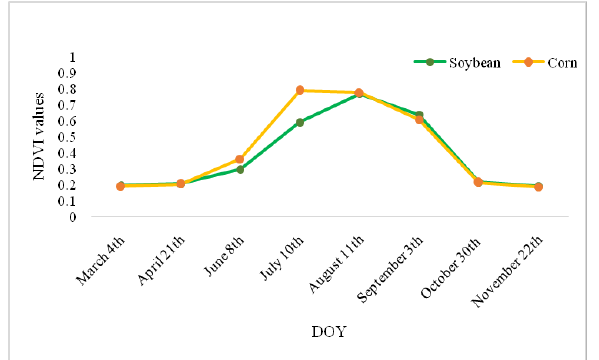
Figure 2 . Extracted phenology curve of NDVI multi-temporal index for corn and soybean